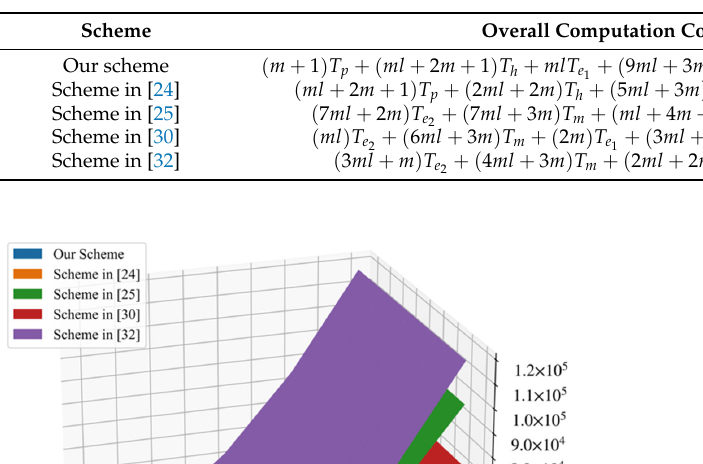
Table 3. The overall computation costs comparison.